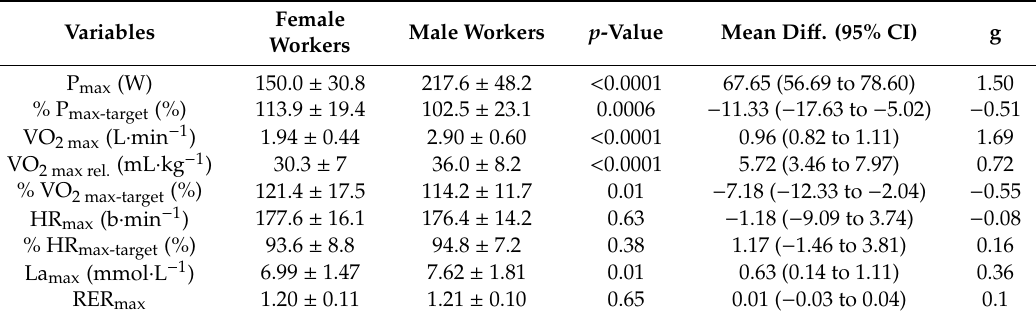
Table 2. Maximal and percentages of standard target values of female and male incremental cycle ergometer exercise test results.